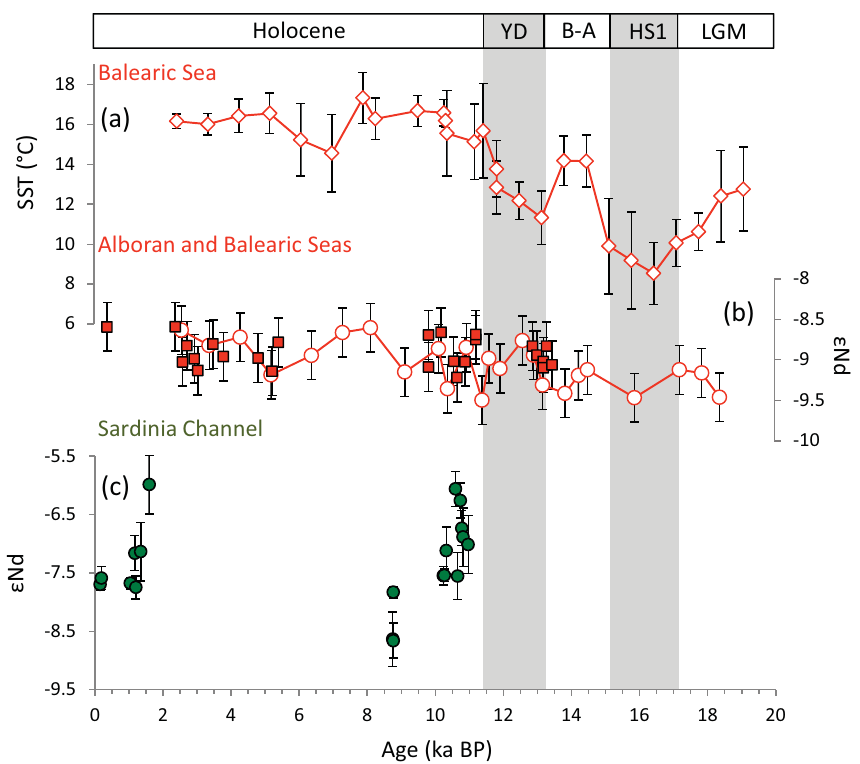
Figure 3. (a) Sea-surface temperature (SST) record of core SU92-33 (red line), (b) ε Nd records obtained on mixed planktonic foraminifers from core SU92-33 (open circles) and from cold-water coral fragments collected in the Alboran Sea (red squares) and (c) ε Nd values of cold-water corals from core RECORD 23 (Sardinia